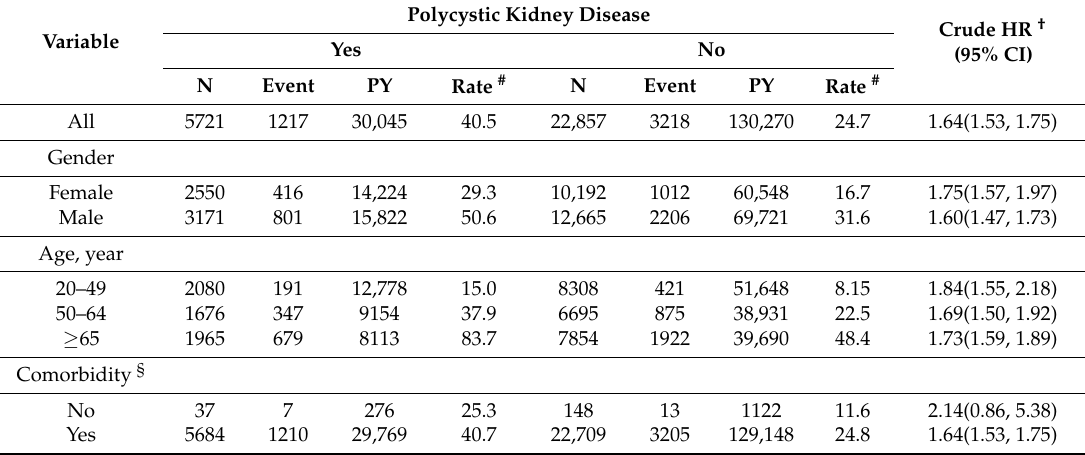
Table 3. Incidence and hazard ratio of mortality between patients with and without polycystic kidney